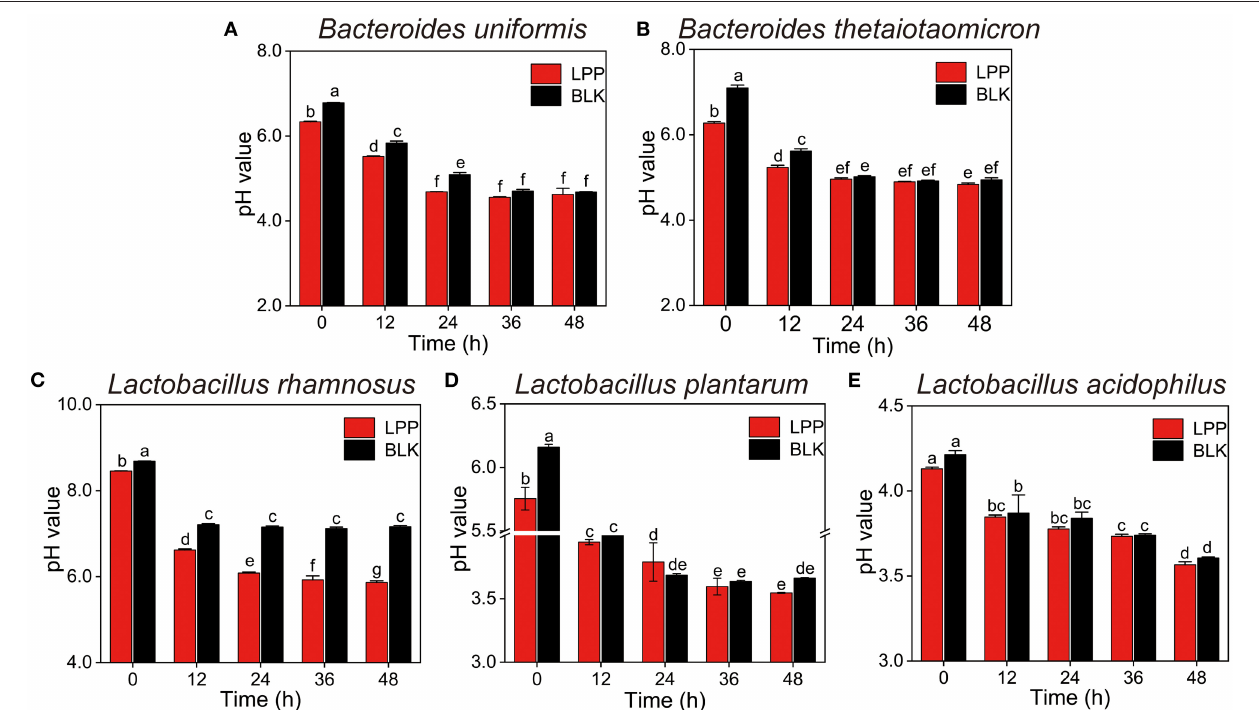
FIGURE 1 | Changes in pH values of five microbial cultures during fermentation with lychee pulp phenolics (LPP). The BLK group was fermented with phosphate-buffered saline (PBS) solution. Bars with no letter in common are significantly different ( p < 0.05). (A) Bacteroides uniformis , (B) Bacteroides